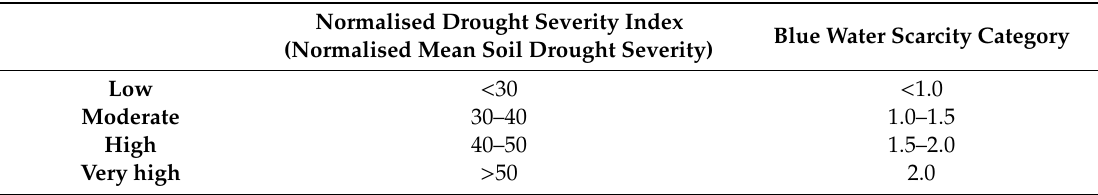
Table 1. Vulnerability levels and corresponding drought severity index and blue water scarcity